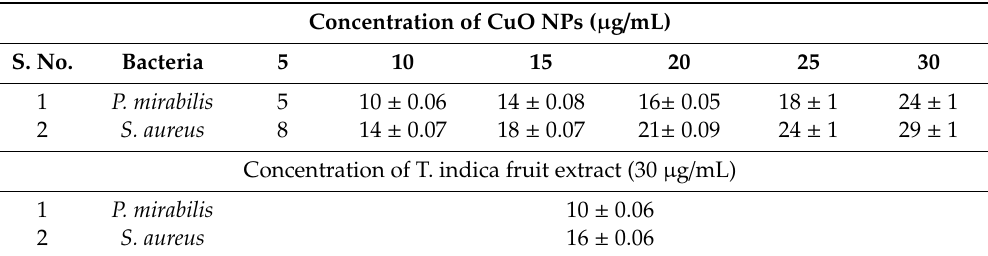
Table 2. Antibacterial activity of CuO NPs (diameter of inhibition zone in mm).